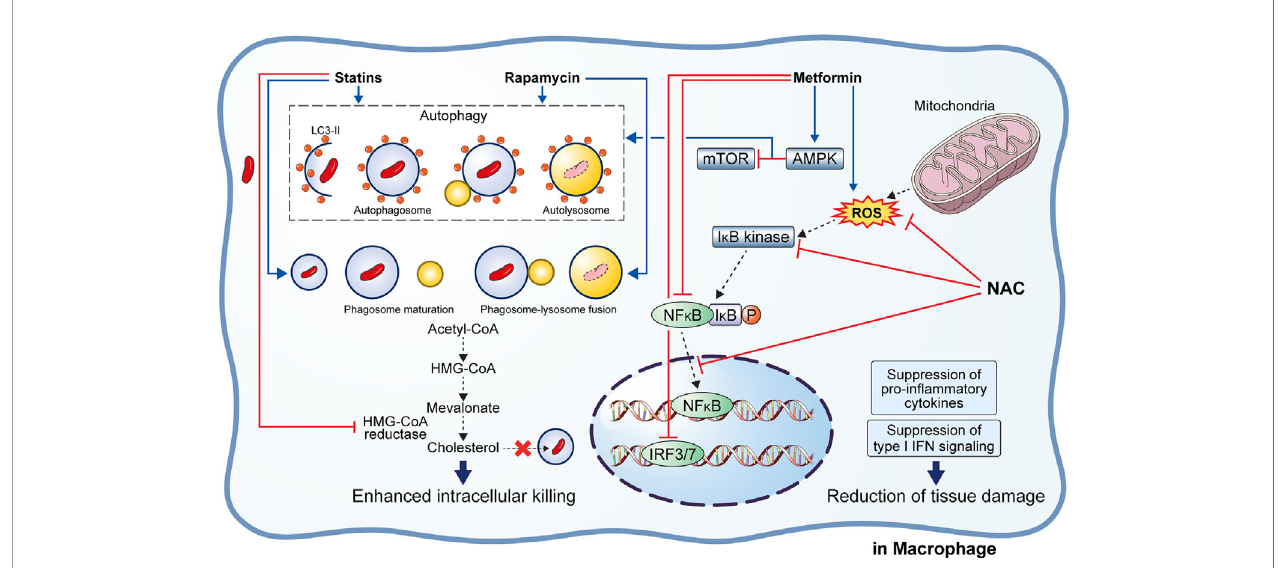
FIGURE 3 | Effect of adjunctive therapeutic agents of anti-TB drugs on host immunity. Various adjunctive drugs aid TB treatment by modulating the host immune response. M. tuberculosis (Mtb) can accumulate cholesterol for use as a source of carbon and energy. Statins bind to the active site of HMG-CoA reductase, thereby inhibiting cholesterol biosynthesis. In addition, statins induce autophagy and phagosome maturation to promote the removal of Mtb. Similarly, rapamycin induces autophagy and phagosome – lysosome fusion to enhance the intracellular killing of Mtb. Metformin inhibits the mTOR complex via AMPK activation in the mitochondria to promote autophagy. Metformin also inhibits ROS production, NF k B signaling, and type I interferon signaling. Similarly, N-acetyl-l-cysteine eliminates the generated ROS and inhibits NF k B signaling. Suppression of pro-in fl ammatory immune response and type I interferon signaling lead to reduced immunopathological severity that bene fi cial to the